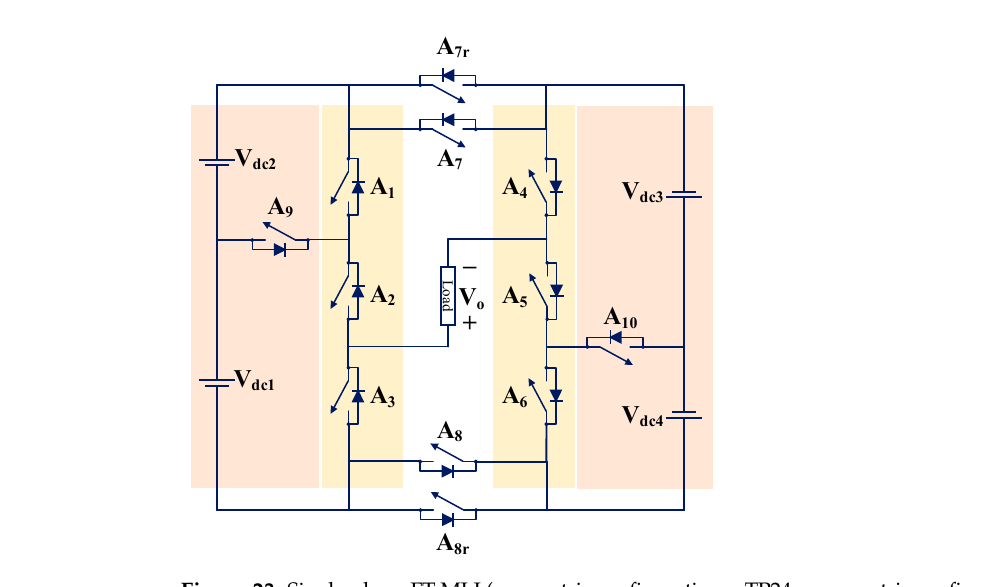
Figure 24. Single-phase five-level FT MLI (TP26) [58].